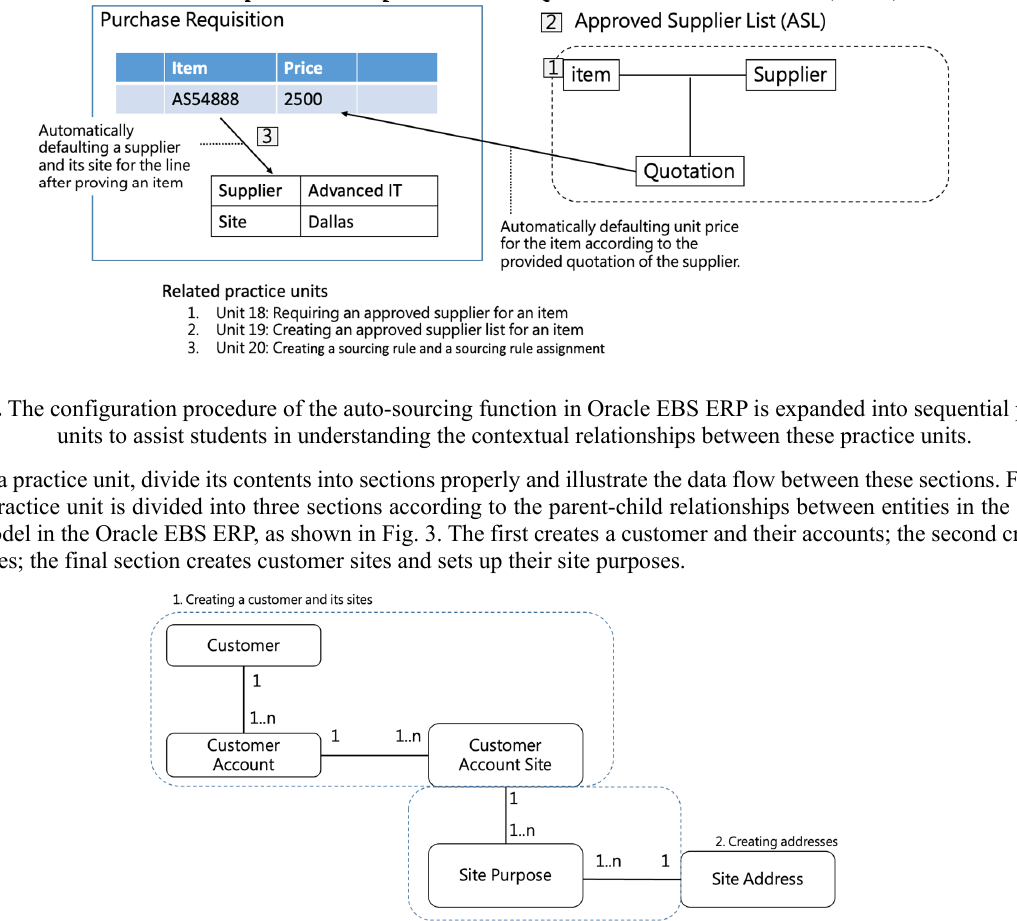
Fig. 1. Labeling material transactions with the corresponding practice units to guide students in choosing the correct proce- dures to complete business processes. The figure is modified from Salvini (2010b).